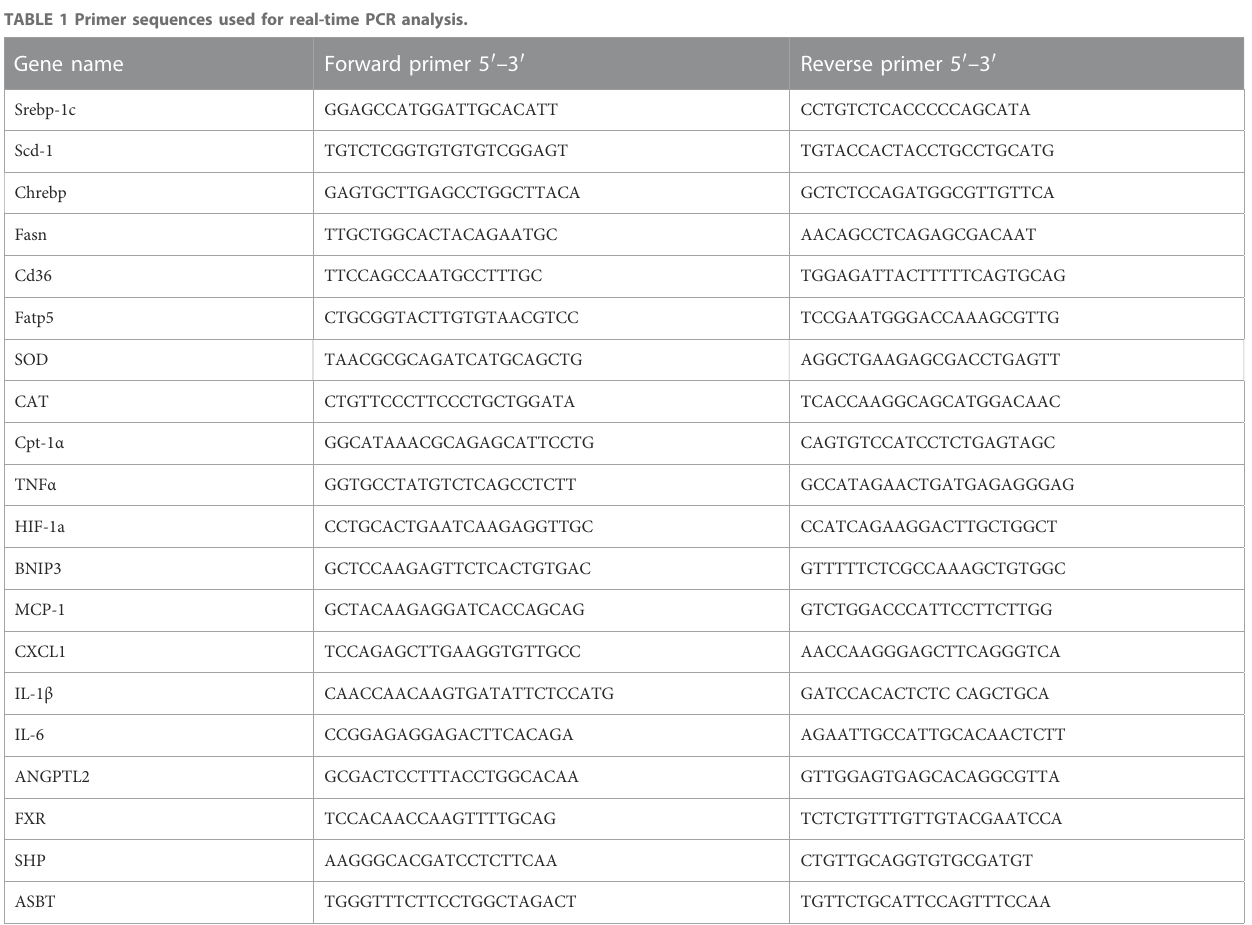
TABLE 1 Primer sequences used for real-time PCR